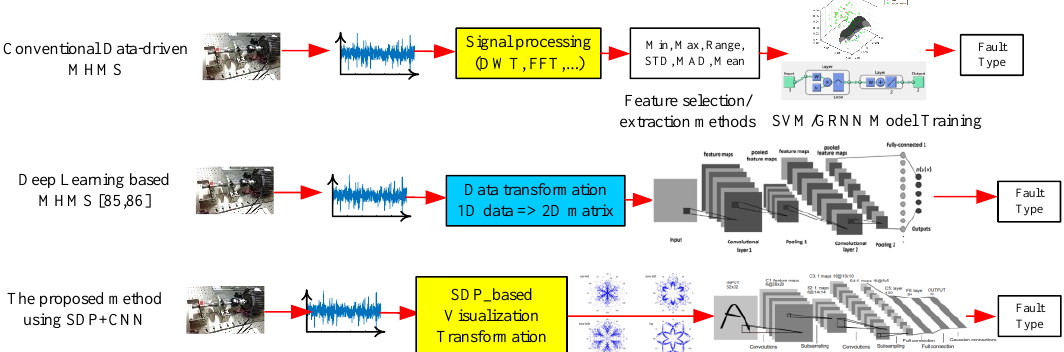
Figure 10. Comparison between the conventional data-driven machine-health monitoring systems (MHMS), the deep-learning-based MHMS, and the proposed method.